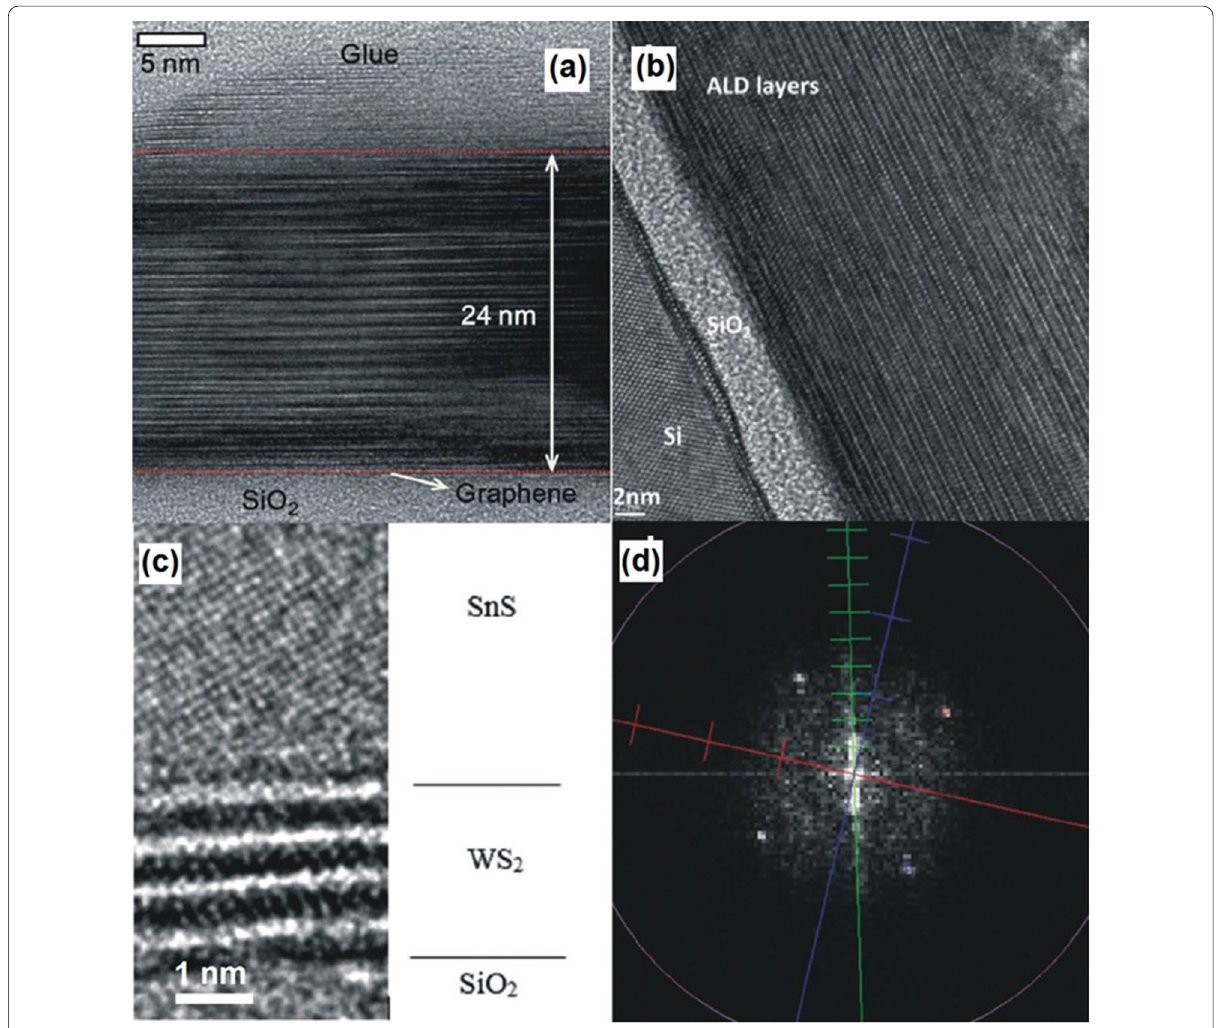
Fig. 7 a Cross-sectional image from the interface between ALD grown Sb 2 Te 3 on graphene/SiO 2 substrate. b The cross-sectional image of heterostructured Sb 2 Te 3 /Bi 2 Te 3 stacked layers. c The HRTEM image of SnS/WS 2 heterointerfaces and d the corresponding fast Fourier transform (FFT) image. Reproduced with permission from